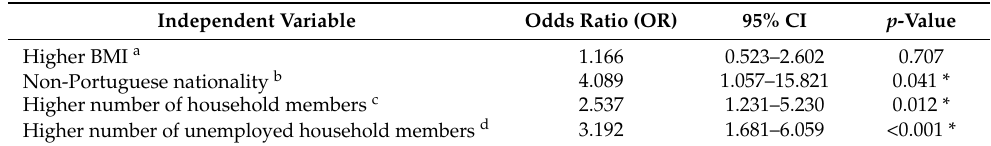
Table 4. Binary logistic regression results of food insecurity status in relation to sociodemographic and student characteristics (n = 284).